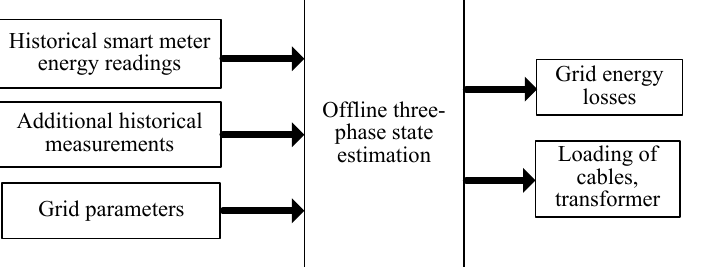
Figure 1. Block diagram of the three-phase distribution-system state estimation (DSSE) for offline analysis of low-voltage (LV)